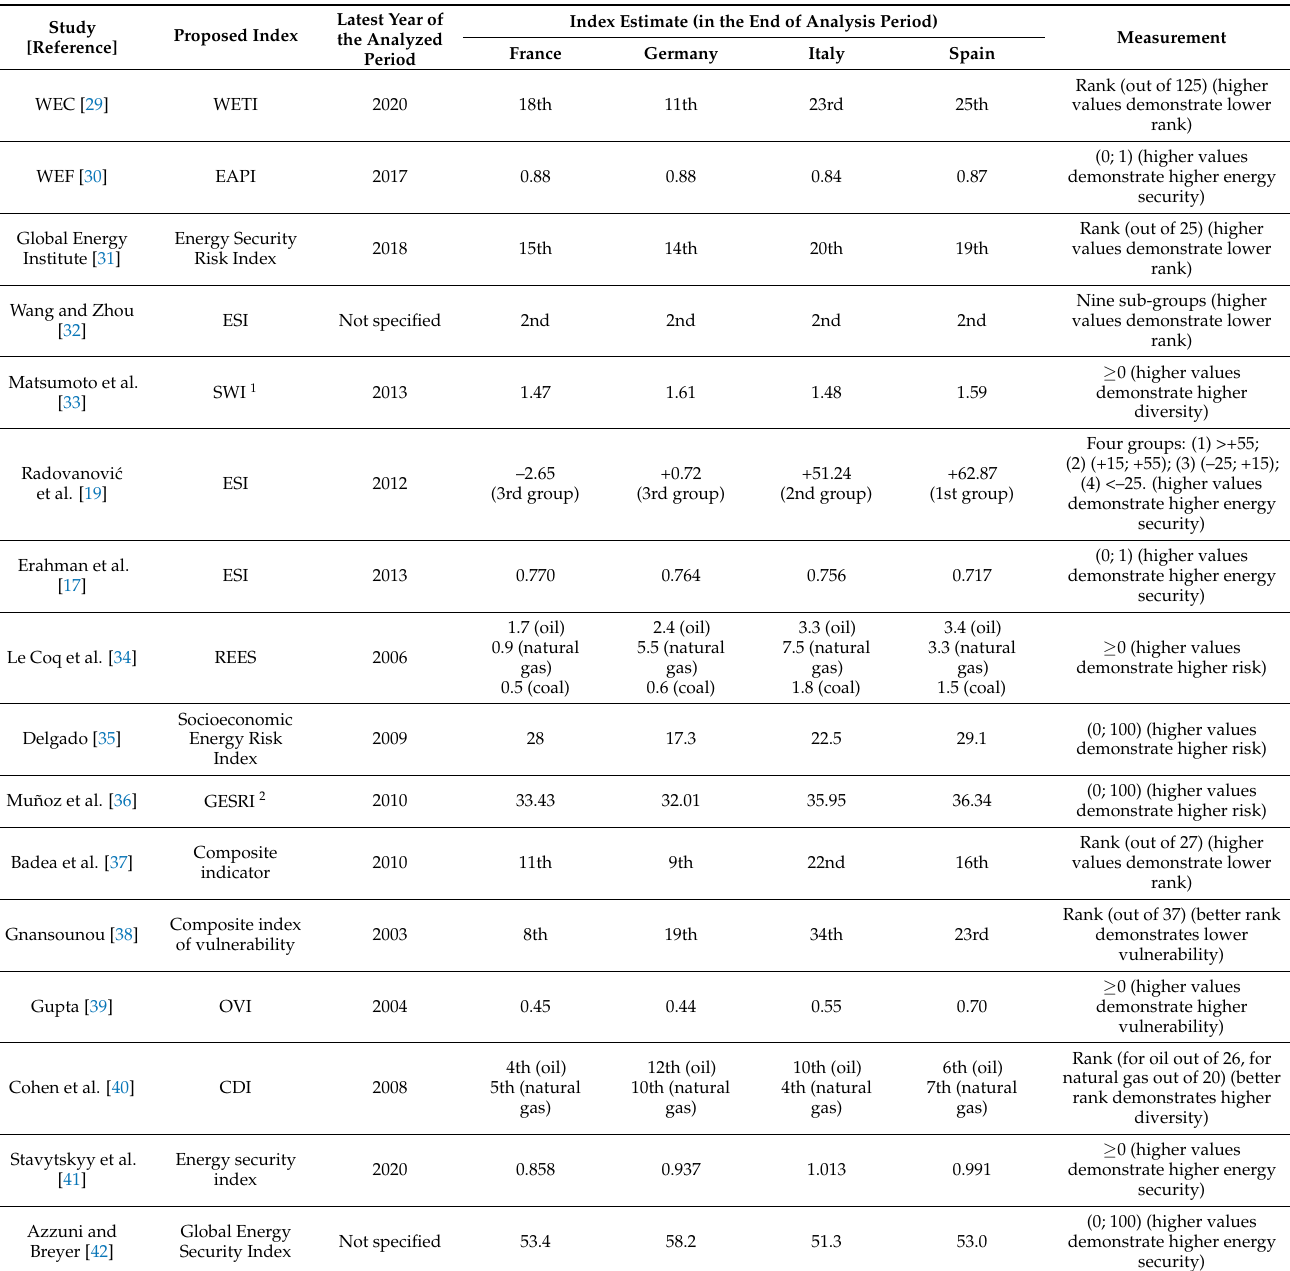
Table 2. Summary of energy security estimates for analyzed countries. Source: own